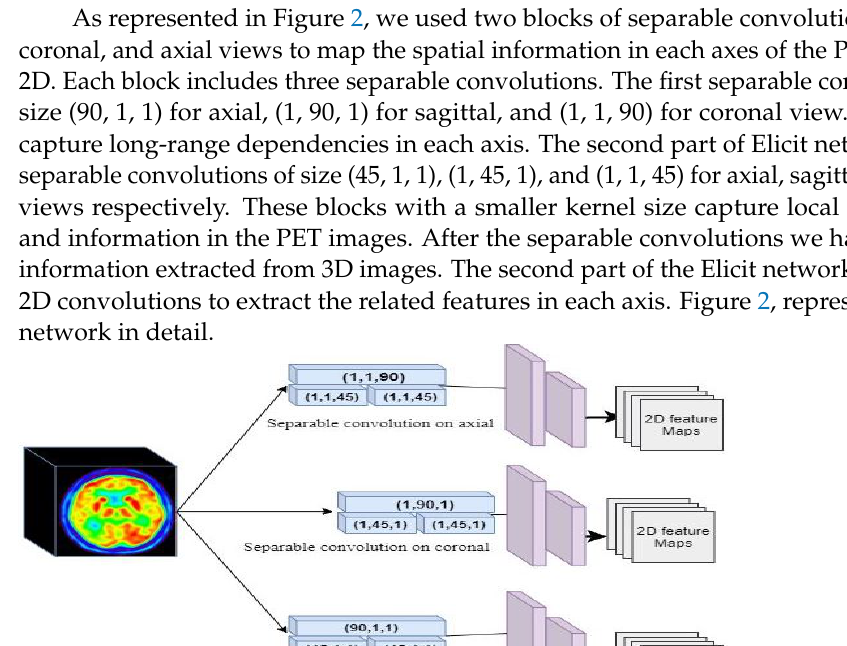
Figure 1. Network architecture of E-GAN for image-to-image translation.